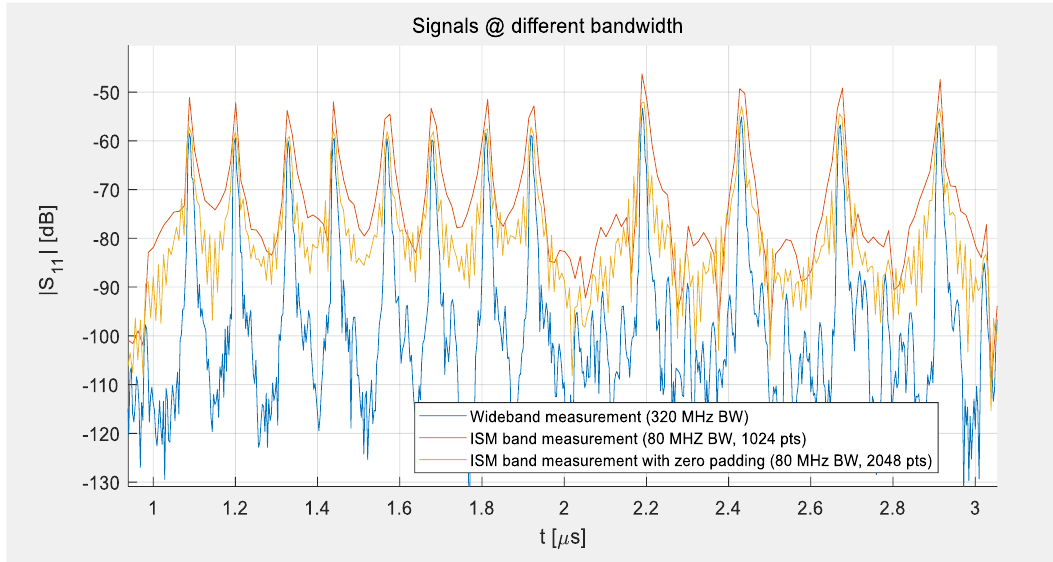
Figure 4. Peaks of the impulse response of the four-sensor-system as measured at different bandwidths at room temperature.